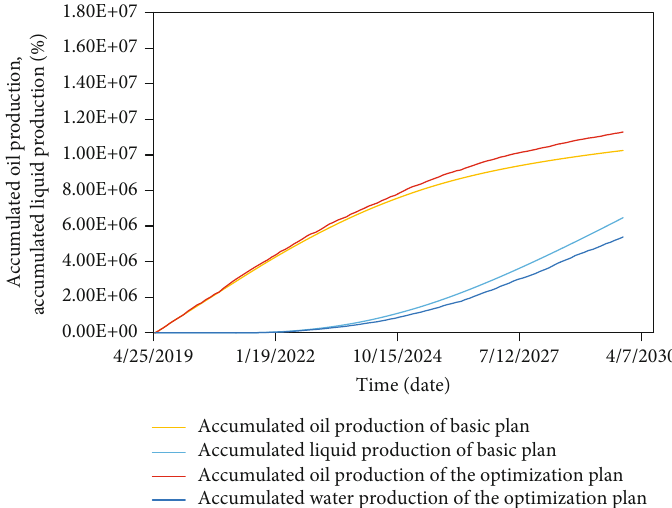
Figure 13: Comparison of accumulated oil and accumulated water.